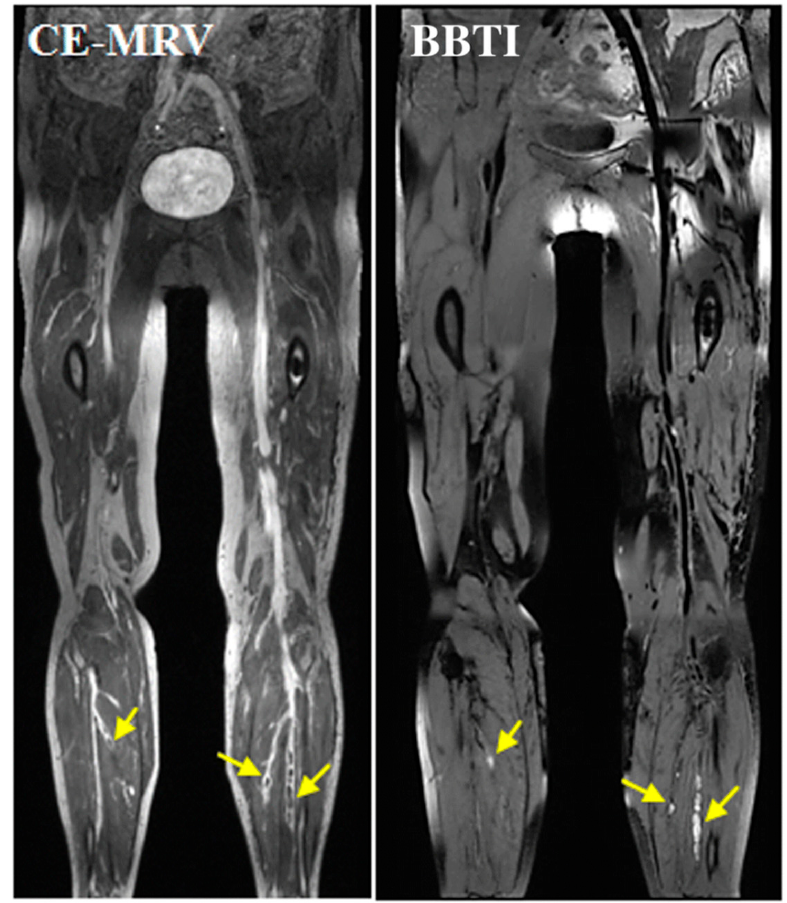
Figure 21. Representative images obtained by CE-CMRV and BBTI from a patient with DVT symptom onset at 10 days. The small thrombus can also be detected by BBTI and matched well with that seen with CE-CMRV (yellow arrows). BBTI—black-blood thrombus imaging; CE-CMRV—contrast-enhanced CMR venography. Reproduced with permission from Chen et al., 2018 [137] .